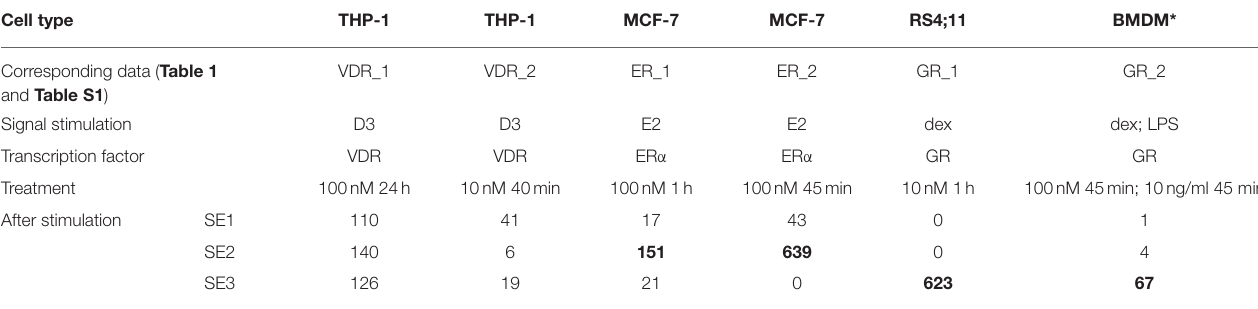
TABLE 2 | The number of signal SE 1–3 for different signals and in different cell types. Cell type THP-1 THP-1 MCF-7 MCF-7 RS4;11 BMDM* Corresponding data ( Table 1 and Table S1